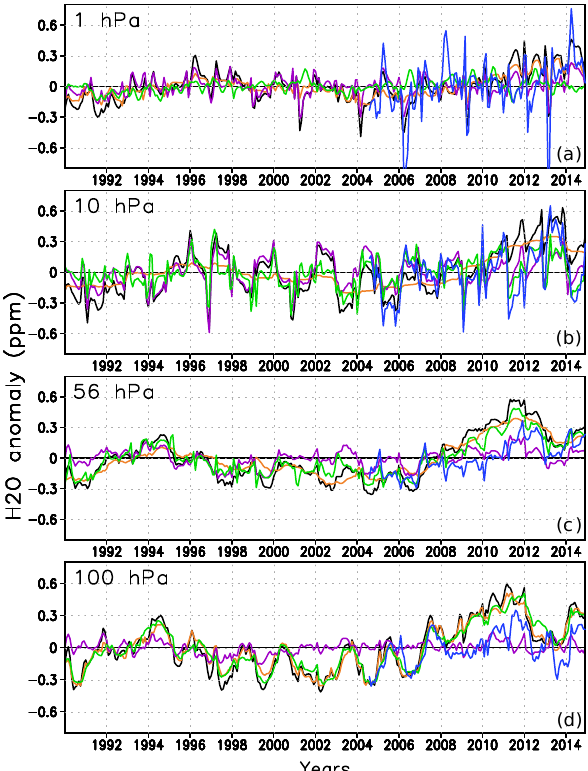
Figure 5. Panel (a) : anomalies of water vapour (black), tracer de- scribing transported water vapour (orange), tracer describing water produced by methane oxidation (purple) from FinROSE, and water vapour anomaly from ECMWF ERA-Interim (green) as parts per million in 1990–2014 and water vapour anomaly from MLS (blue) in 2004–2014. Anomalies are calculated at latitudes between 70– 90 ◦ N at the level of 1hPa. Panels (b – d) : same as panel (a) but at levels of 10, 56, and